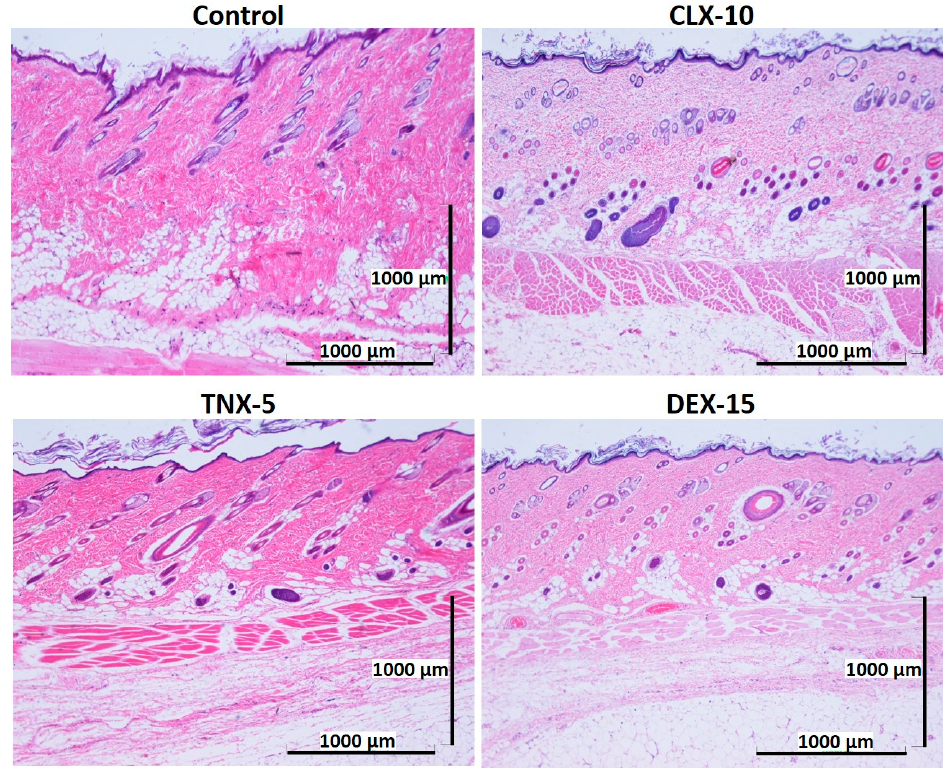
Figure 7. Representative histological photomicrographs of skin cross-sections of rats subcutaneously injected with CLX-10, TNX-5 and DEX-15-loaded NPs compared to the control group after two weeks. (H-E).